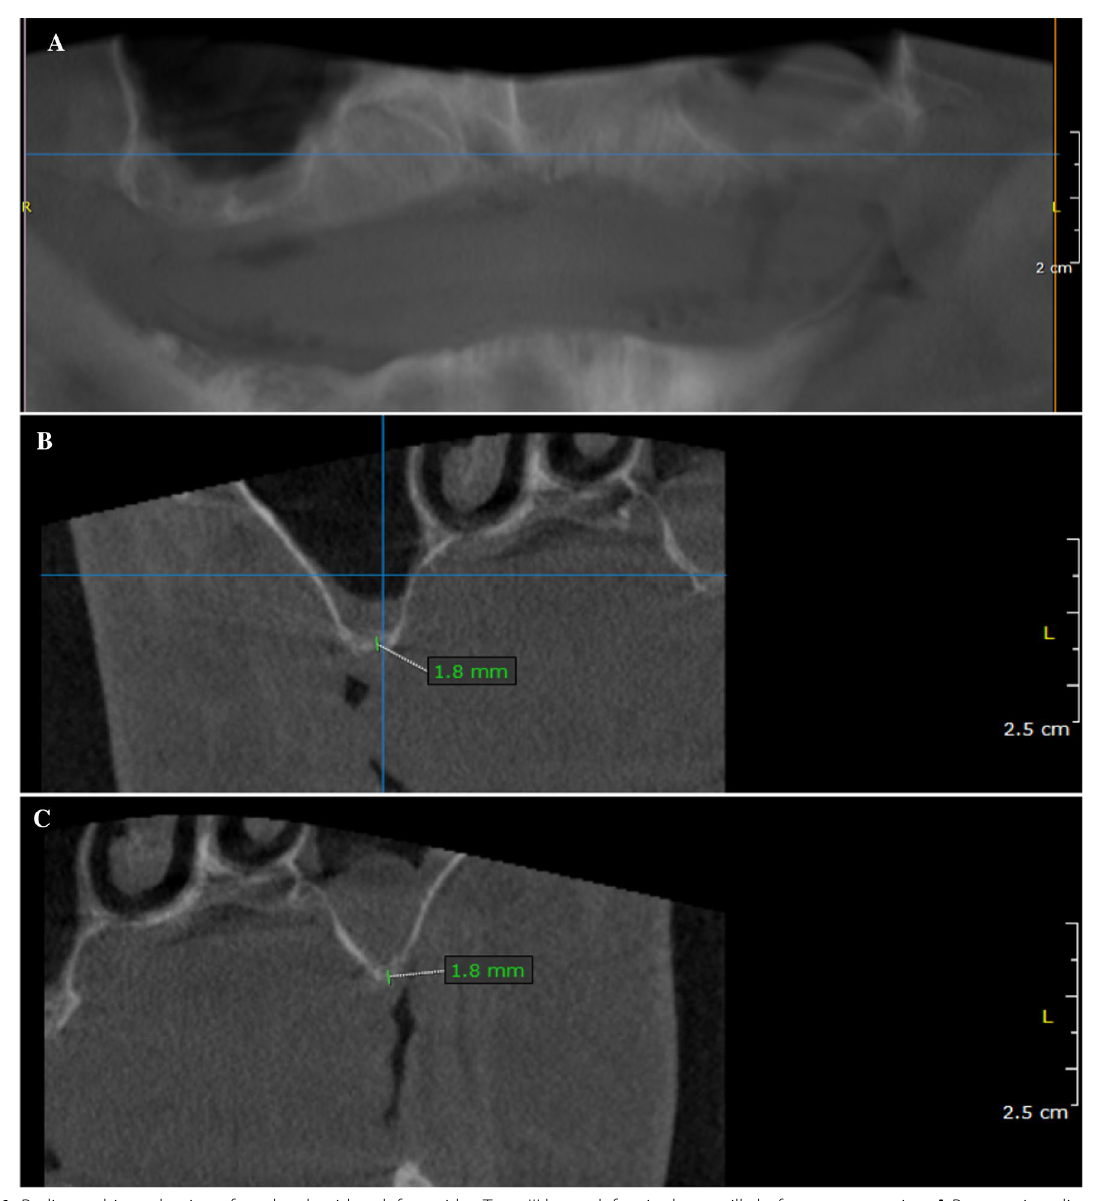
Fig. 1 Radiographic evaluation of an alveolar ridge defect with a Type‑III bone defect in the maxilla before augmentation. A Panoramic radiograph demonstrated massive bone loss in the right and left maxilla. The patient showed local swelling of the basal maxillary sinus mucosa during the preliminary examination. After assessment by an otorhinolaryngologist, the patient had a clinically asymptomatic situation and there was no objection to augmentation of the sinus. B Sagittal section of the CBCT illustrating the region of interest in the first quadrant. C Sagittal section of the CBCT illustrating the region of interest in the second quadrant. The green line corresponds to the vertical height of the bone in the defect area before